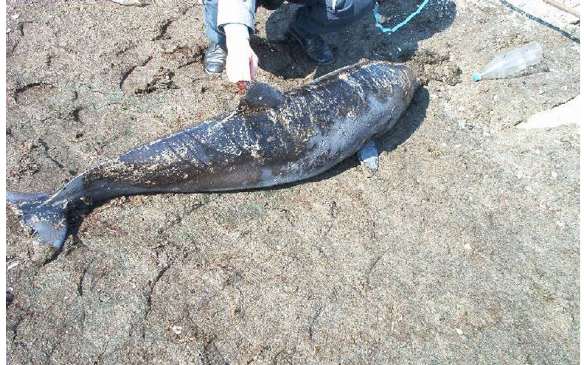
Fig. 7. – Stranded Phocoena - marks produced by the mesh nets.